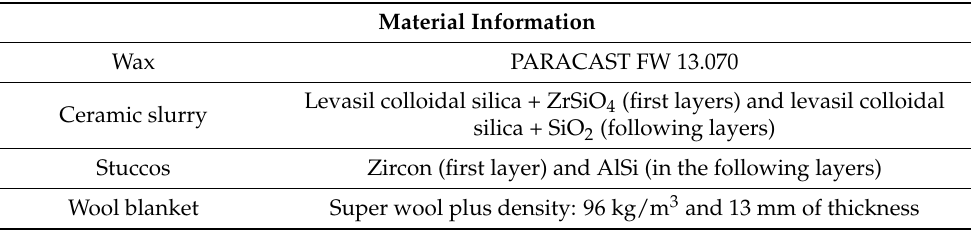
Table 3. Materials used to prepare the set of wax model, shell mould, and thermal